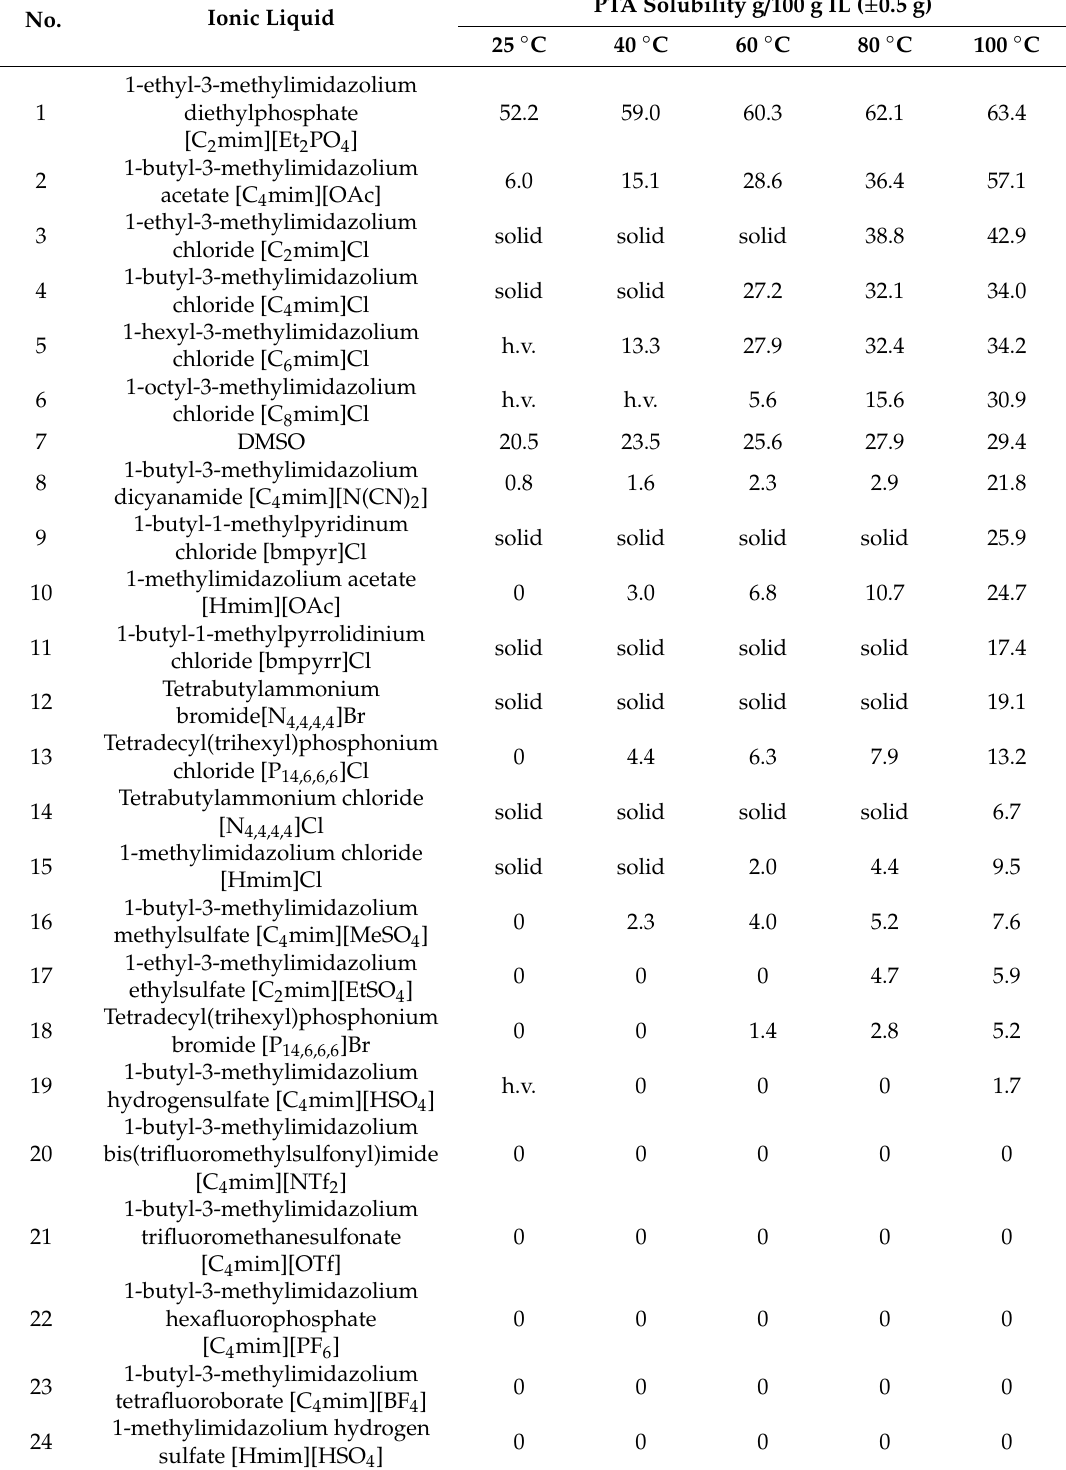
Table 2. Solubility of PTA in ionic